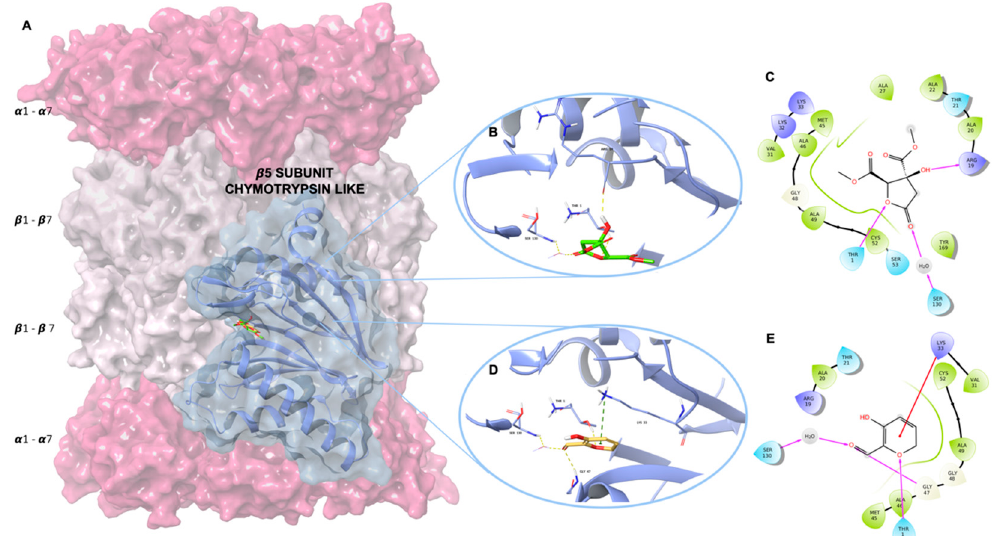
Figure 3. 3D representation of ( A ) human 20S proteasome with a focus on the β 5 chymotrypsin like subunit; ( B ) Hib-ester and ( D ) Hib-carbaldehyde docked into the proteasome chymotrypsin-like binding pocket. The Hib-ester and the Hib-carbaldehyde are depicted, respectively, as green and yellow carbon sticks, the proteasome is shown as a light-blue cartoon and the enzyme residues involved in crucial contacts with the compounds are reported as light-blue carbon sticks. The water molecule is shown as red carbon sticks. Hydrogen bonds and pi-cation contacts are shown, respectively, as dashed yellow and dark-green lines. 2D representation of ( C ) Hib-ester and ( E ) Hib-carbaldehyde complexed into the proteasome chymotrypsin-like binding pocket. In the 2D representation, hydrogen bonds and pi-cation contacts are shown, respectively, as violet and red lines.